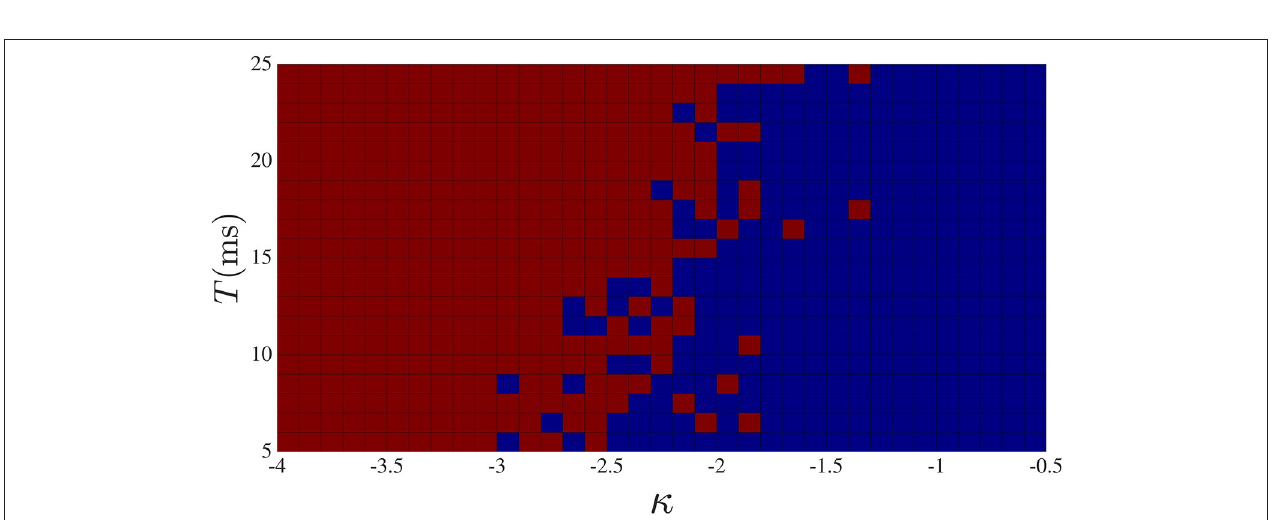
FIGURE 6 | Activity drop-out phase diagram in κ - T space. Red squares correspond to the cases where at least one activity drop-out was observed during 35 s, and blue squares for the cases with no activity drop-out. Stronger and/or longer delay global feedback are seen to promote drop-outs.